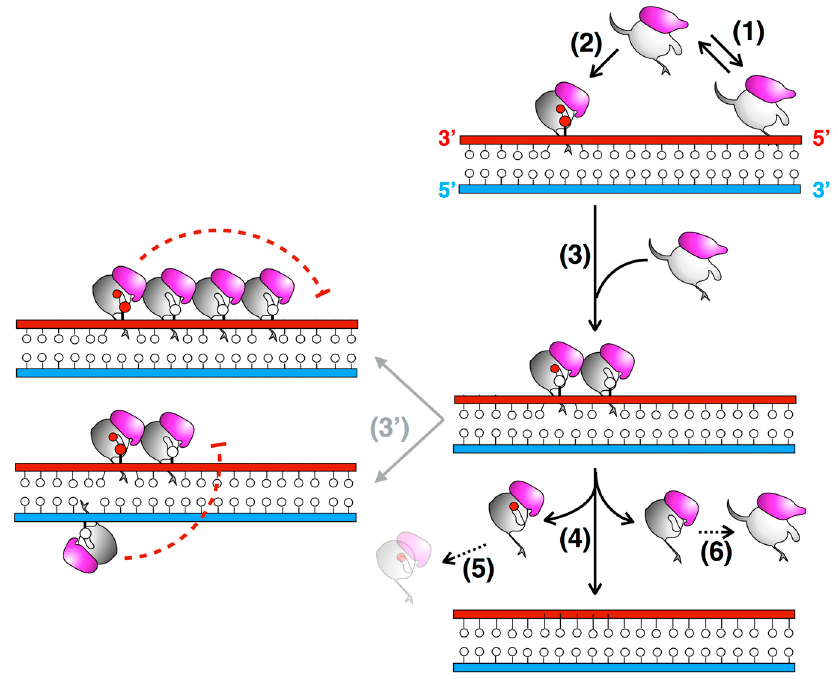
Figure 4. Proposed DNA repair mechanism involving Mt OGT. Sub-optimal OGT binding to undamaged dsDNA could result in protein-DNA complex dissociation (1); when a lesion is encountered, conformational modifications could take place (2), leading to the recruitment of additional OGT subunits tightly packed at a few bases apart, where they check the DNA for further modified bases (on both strands) (3). However, the formation of a continuous protein coat onto dsDNA could be hampered by long- and short-range steric hindrance phenomena (red dashed T-bars) (3 ′ ), until the protein-DNA complex disassembles upon repair (4). The final fate of alkylated MtOGT (5) and the capability of the released, un-reacted protein monomers to undergo further conformational changes (6) are still unknown (black dotted arrows) (adapted from [45]).